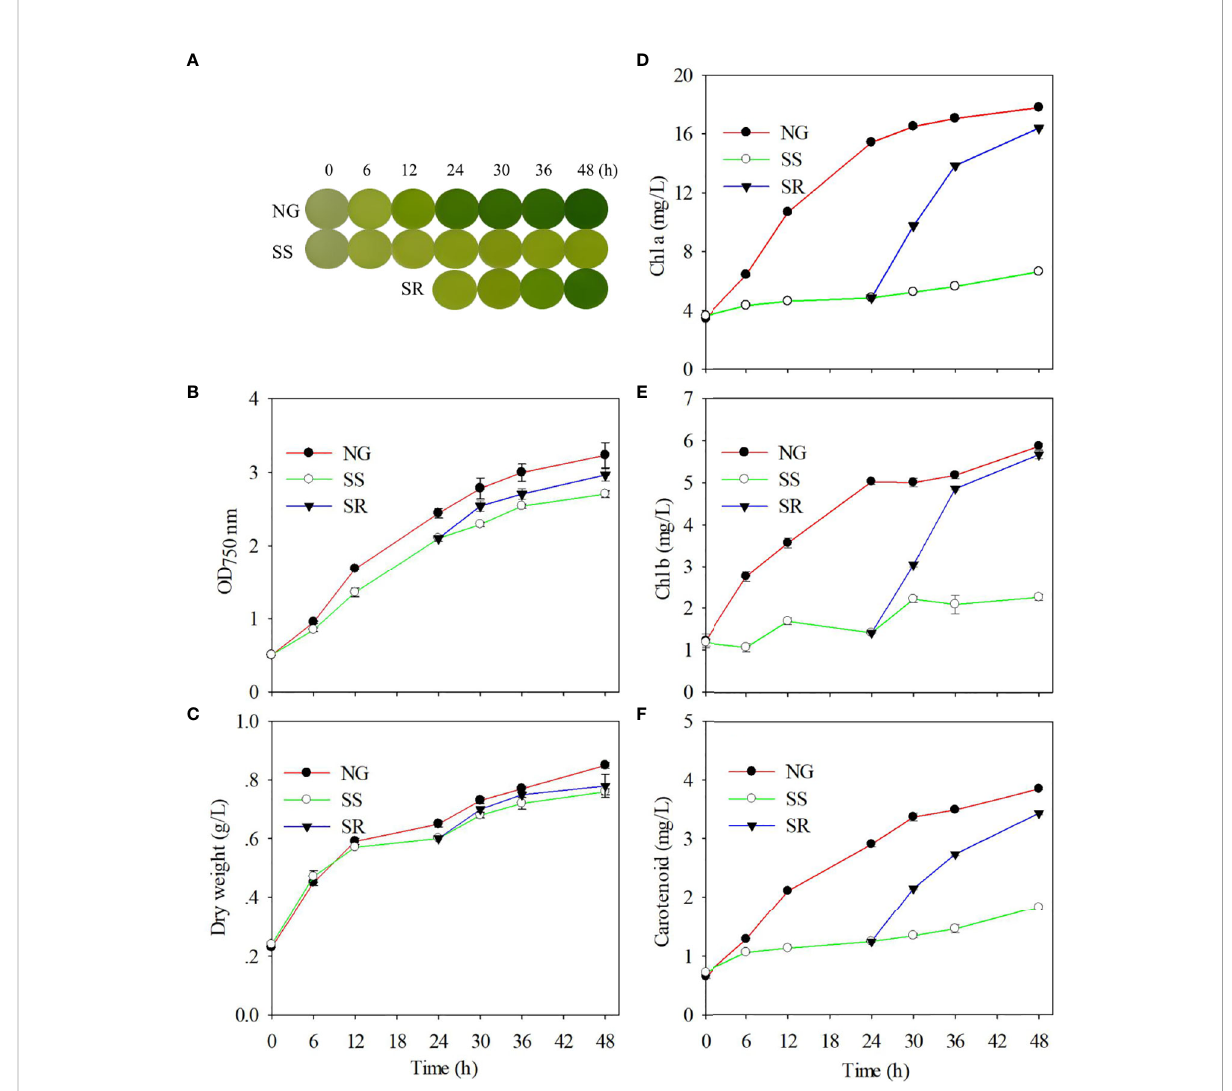
FIGURE 1 Effect of sulfur nutritional status on phenotype (A) ; optical density during growth (B) ; dry biomass accumulation (C) ; and contents of chl a (D) , chl b (E) , and carotenoid (F) of C. sorokiniana. NG, normal growth; SS, sulfur starvation; SR,